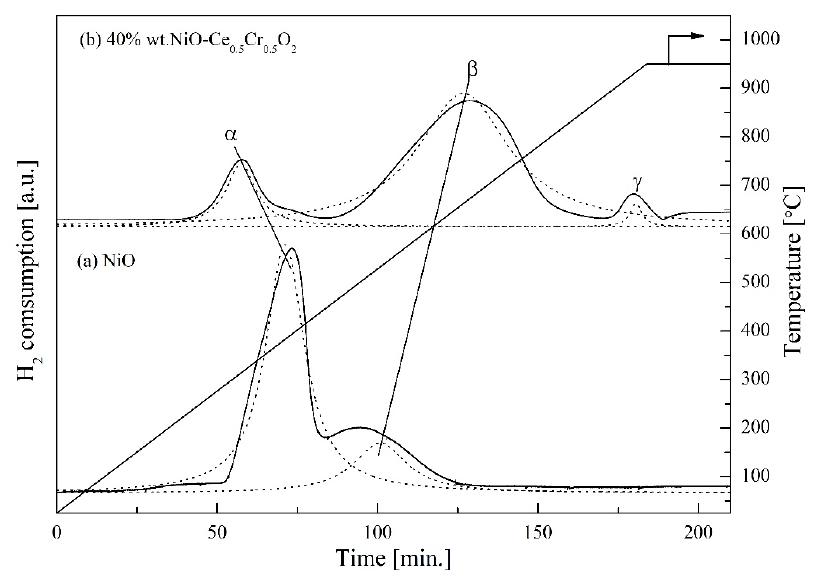
Figure 2. H 2 -TPR profile of ( a ) pure NiO used as reference and ( b ) 40 wt% Ni-CeO 2 /Cr 2 O 3 catalyst calcined at 500 °C. Where α , β , and γ are weak, moderate and strong peak interaction temperature, respectively.